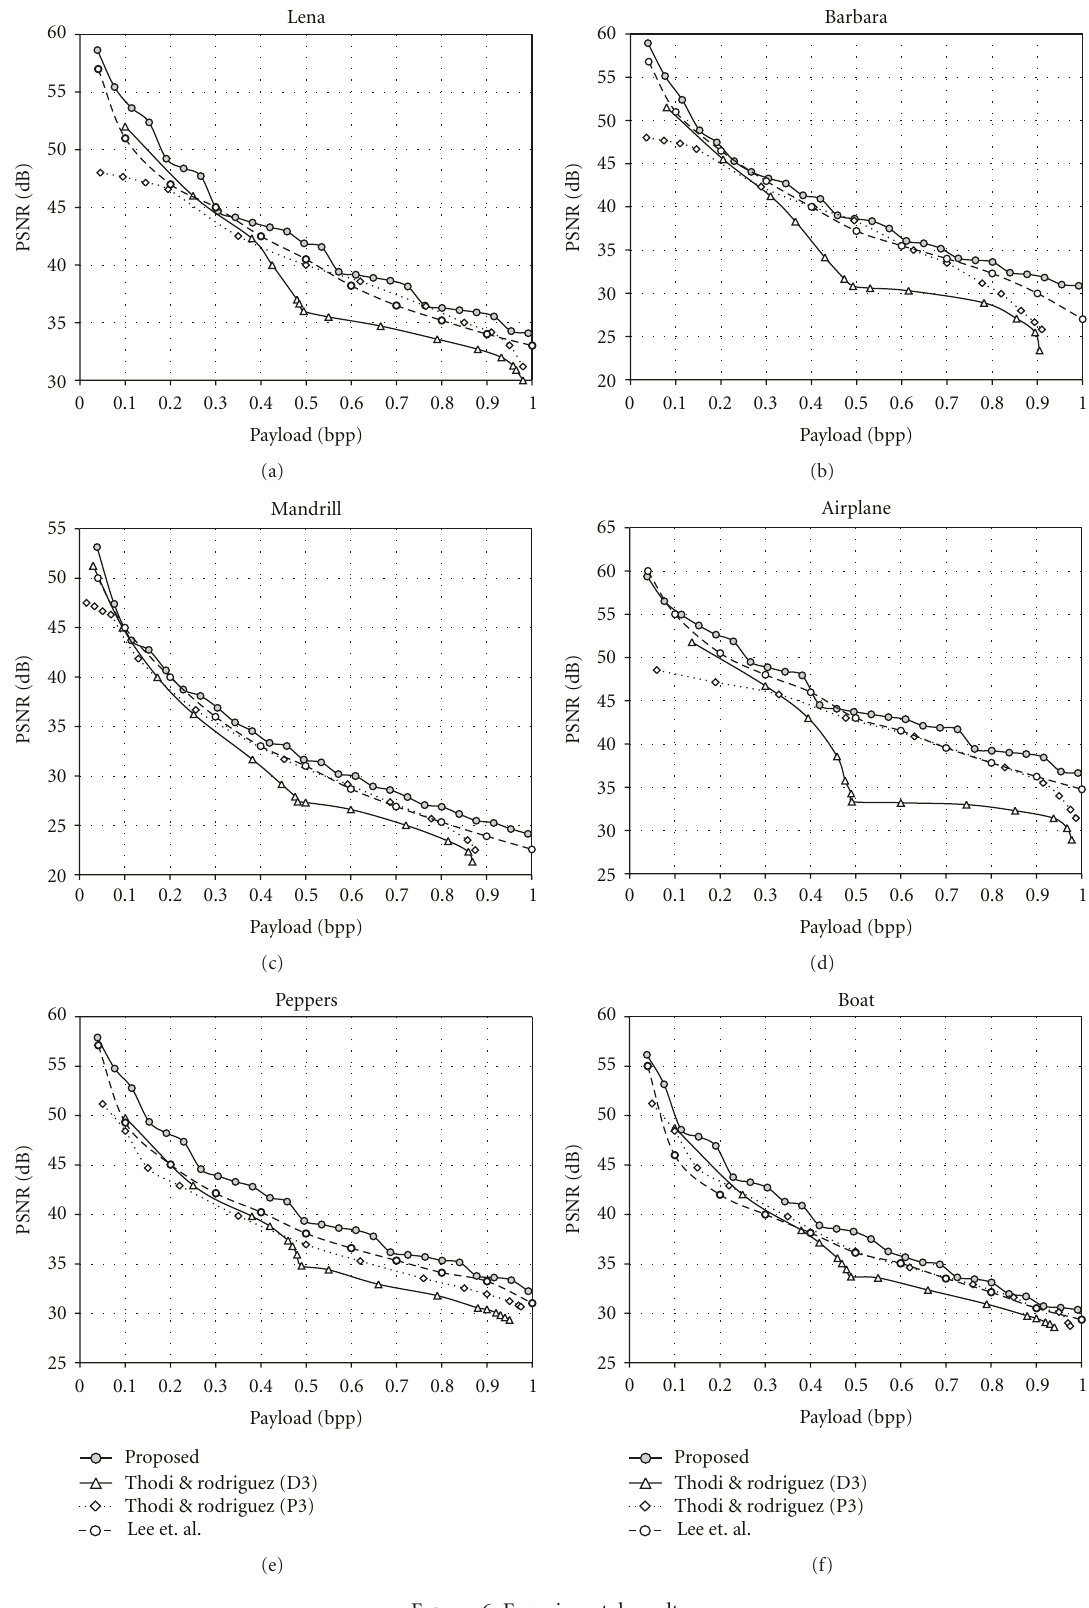
Figure 6: Experimental